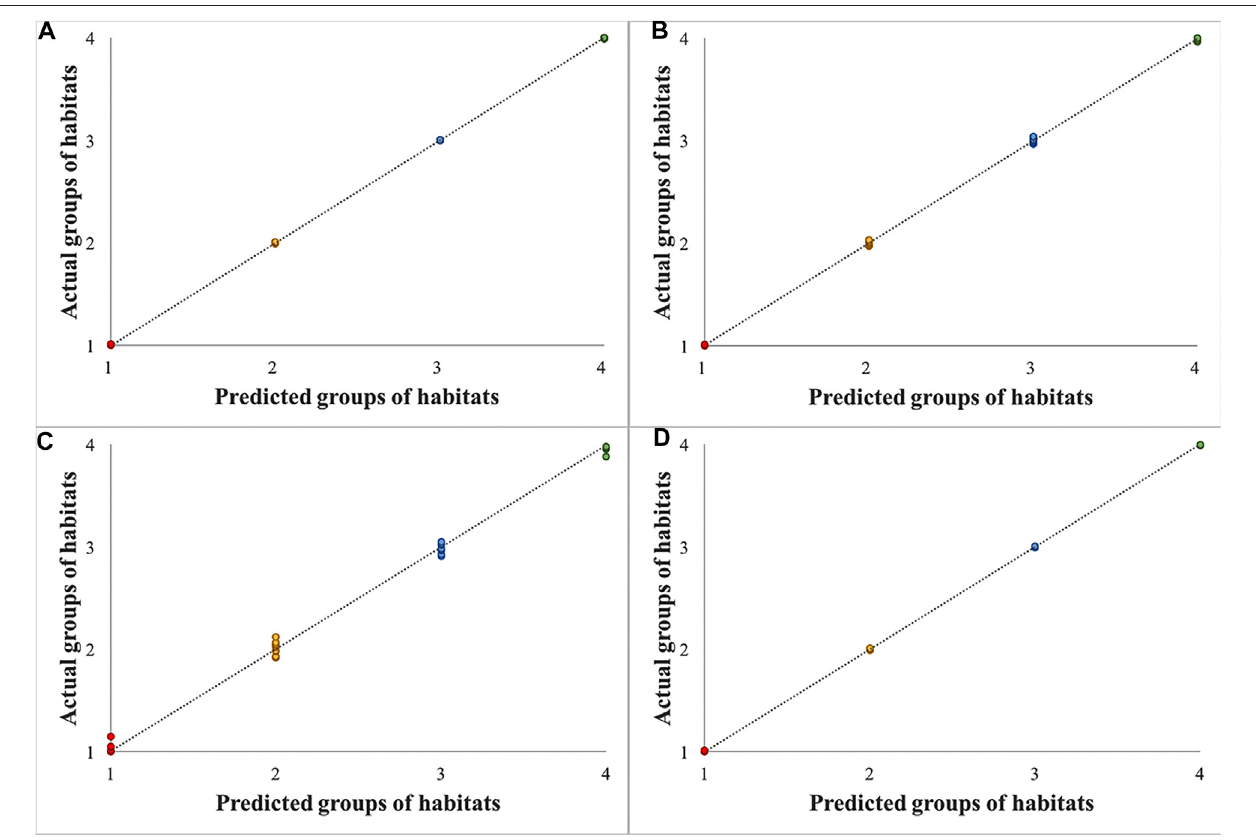
FIGURE5| Results ofpartial leastsquare(PLS) regression modelsfor samplesofthedriedroot of Isatis indigotica from fourhabitatsbasedon massspectrometry imaging (MSI) data in the spectral ranges of m / z 100 – 500 in a positive mode (A) , m / z 500 – 1,000 in a positive mode (B) , m / z 100 – 500 in a negative mode (C) , and m / z 500 – 1,000 in a negative mode (D) .